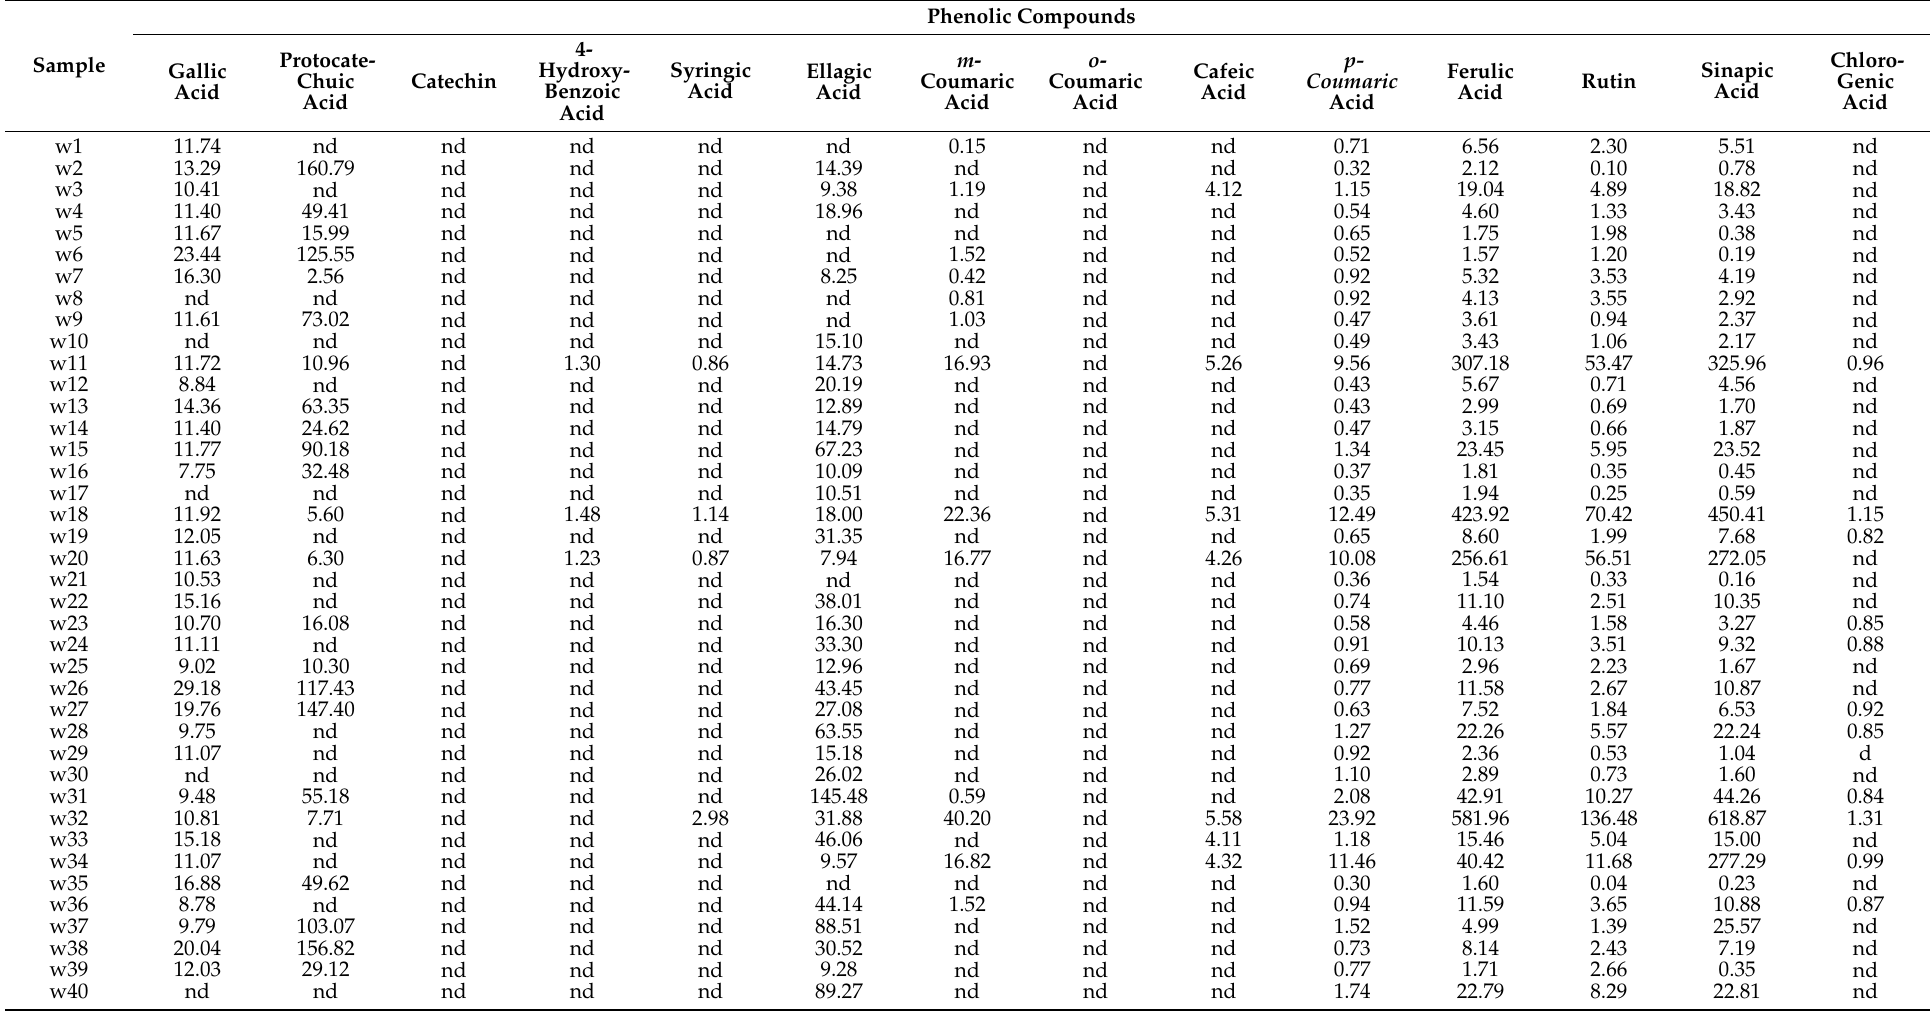
Table 4. Bound phenolic compounds of purple wheat samples ( µ g/g of dry